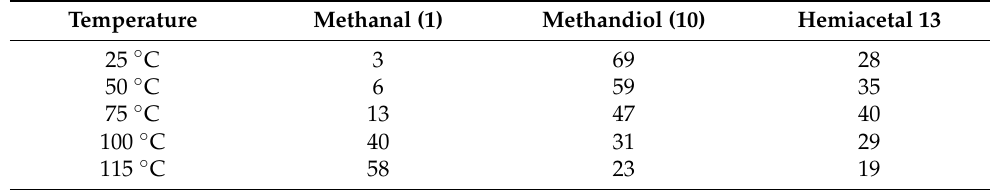
Table 1. The molar ratios of selected compounds at various temperatures for formalin in DMSO- d 6 .